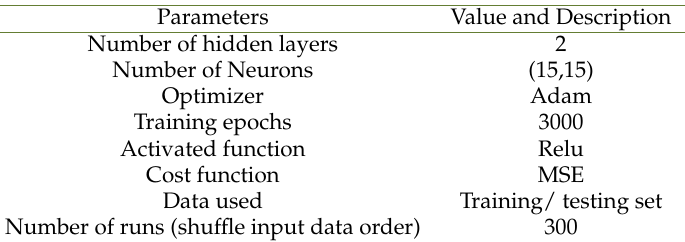
Table 2. Initialization hyper parameters of DNN model